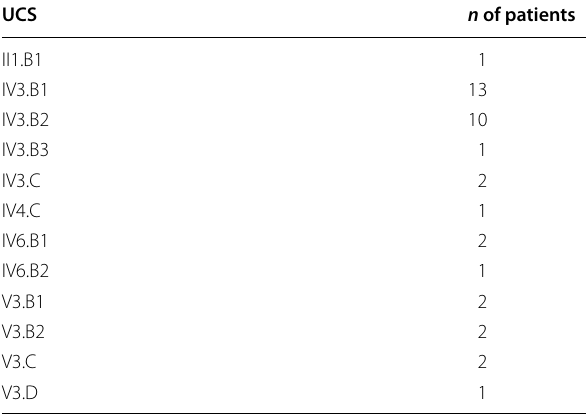
Table 1 Types of fractures according to the Unified Classification System